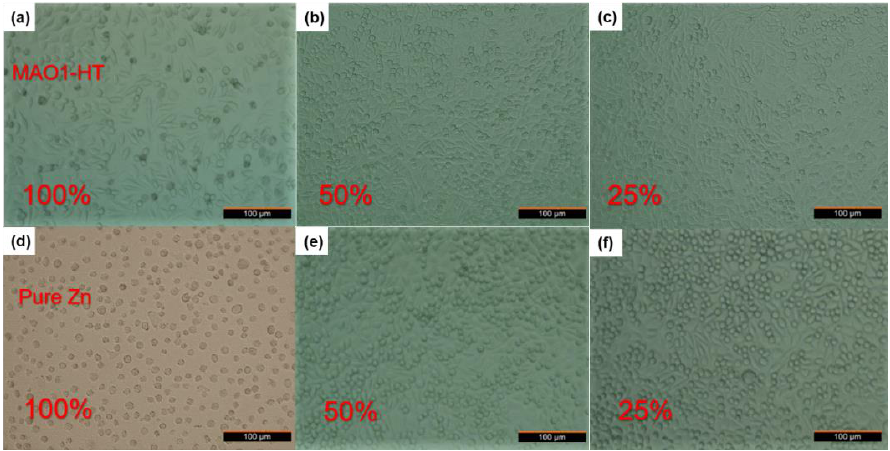
Figure 7. Morphologies of cells in different concentration of extract culture solution. ( a – c ) MAO1−HT and ( d – f ) pure Zn. Table 4. ICP-OES results of elements in pure Zn and MAO1−HT cell culture solution. Element